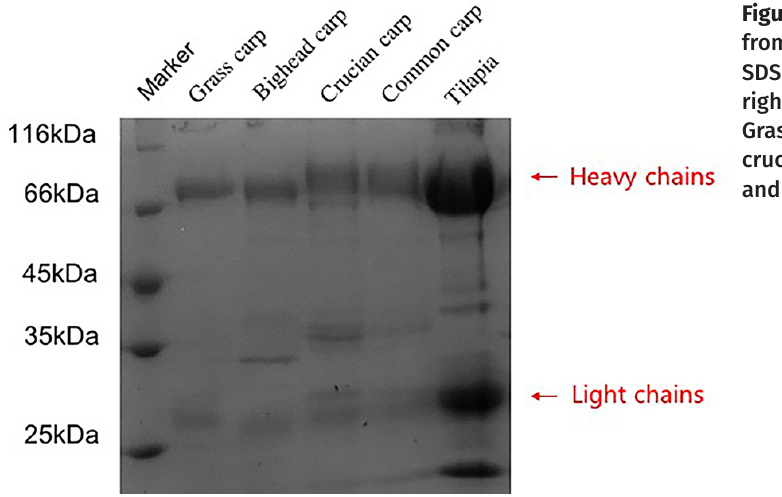
Figure 1. Purification of IgMs from fishes identified by SDS-PAGE. Lanes from left to right were MW marker (M), Grass carp, bighead carp, crucian carp, common carp, and tilapia.